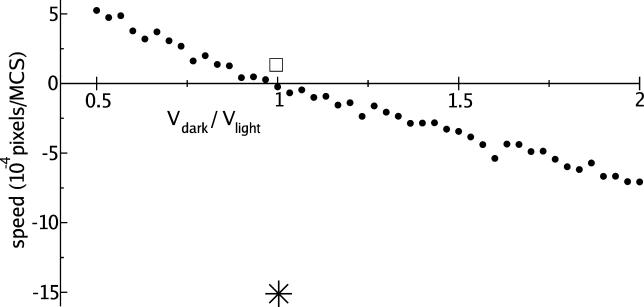
Size-Based Cell Sorting in a Confined Cell MassThe graph shows the rate by which the mean position of the dark cells shifts, relative to the mean position of the light cells, averaged over 50,000 MCS. Positive values indicate forward movement of the dark cells. The graph shows that small cells move forward, while large cells move backward. For both Vdark/Vlight < 1 and Vdark/Vlight > 1, the graph is approximately linear, with y = 9.99 · 10−4(1 − x), and y = 7.18 · 10−4 (1 − x), respectively (for both line segments, the correlation coefficient is 0.990). Jl,l = Jd,l = Jd,d = 5, Jd,m = 4, Jl,m = 5, T = 6, λ = 12, μ = 2, Hb = 0.8, and Vl = 60. The square and star indicate the effective volume ratios versus shifting rates for Figure 5A–5C and Figure 5D–5F, respectively.